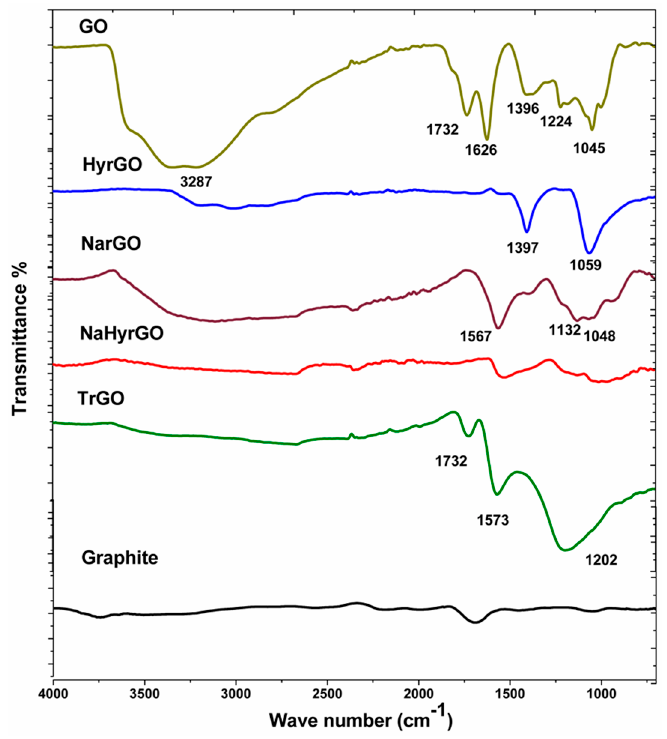
Figure 1. FT-IR spectra of graphite, GO and different reduced GOs.